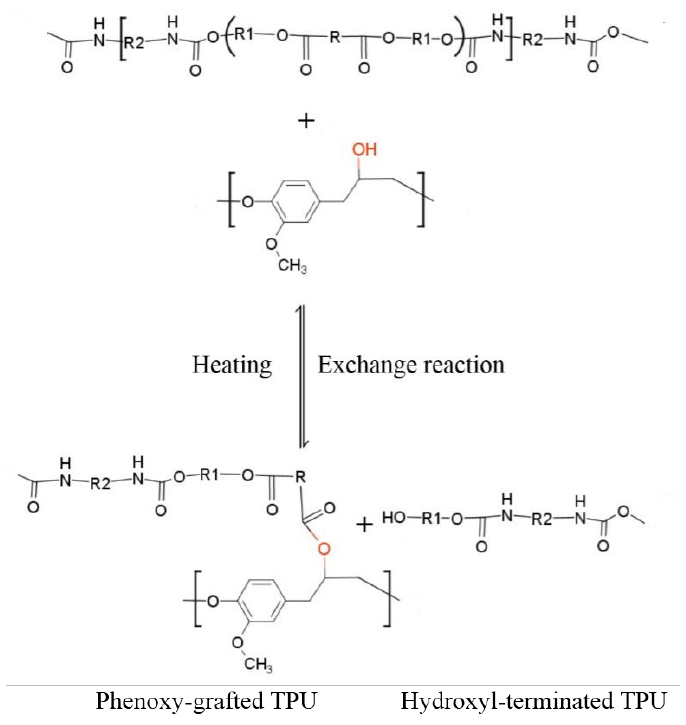
Figure 7. Schematic of the exchange reaction between ester TPU and phenoxy resin.